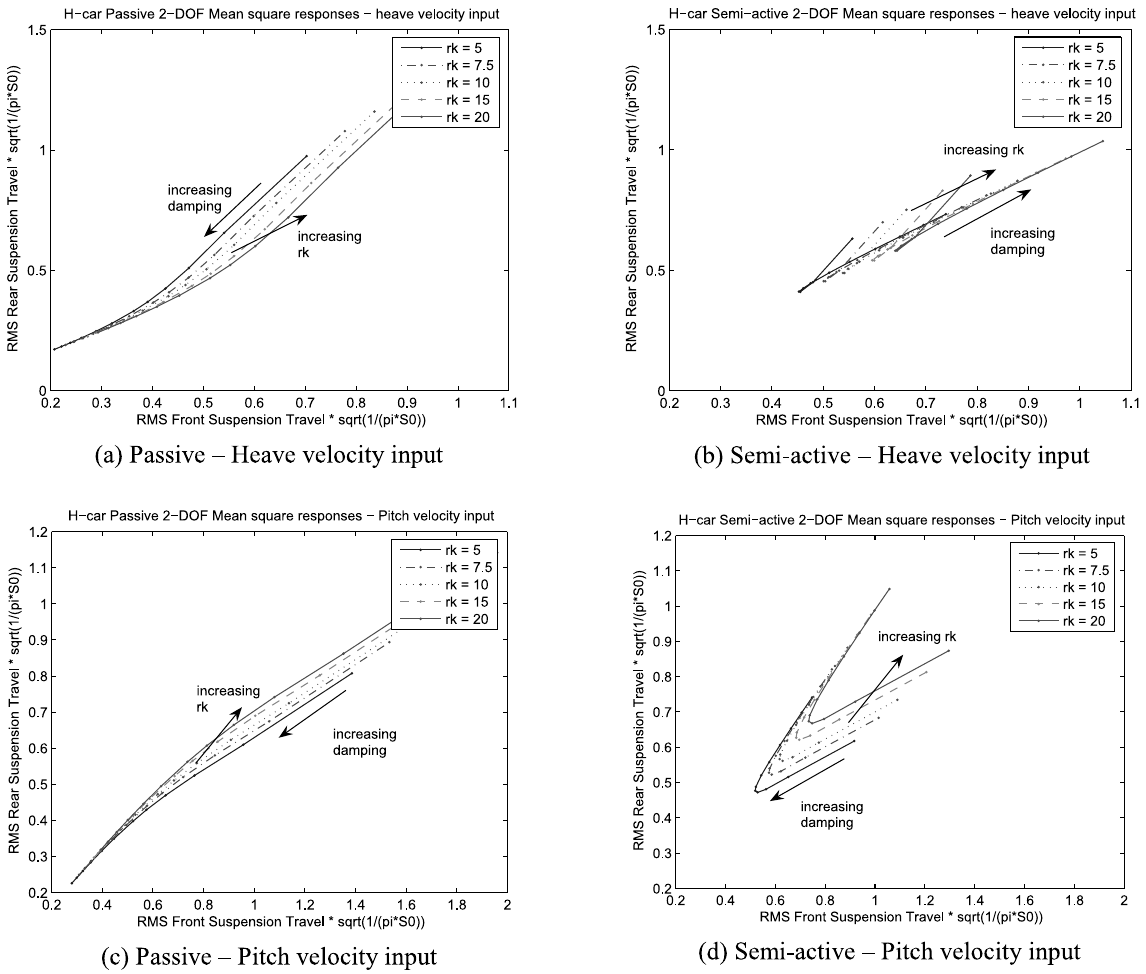
Fig. 8. Relationship between the rms rear suspension deflection to rms front suspension